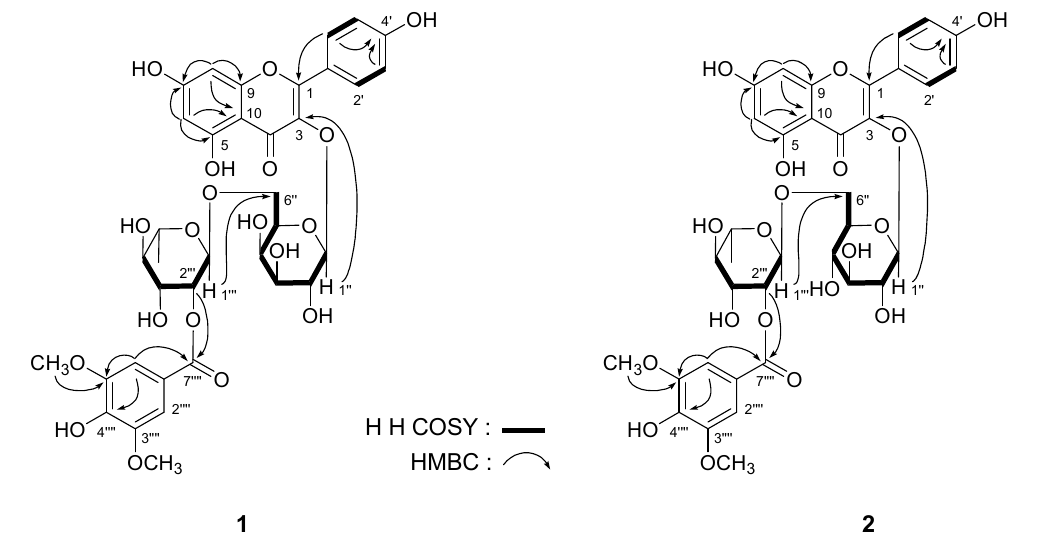
Figure 2. The main 1 H- 1 H COSY and HMBC correlations of compounds 1 and 2